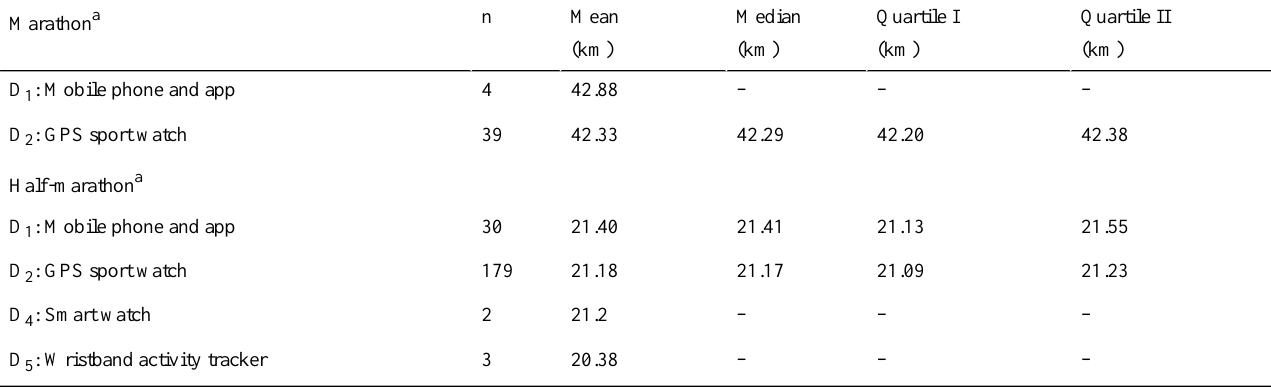
Table 4. Mean, median, and I and II quartiles of the recorded distances for the full and half-marathon. Median and quartiles are not reported for categories that had <10 data